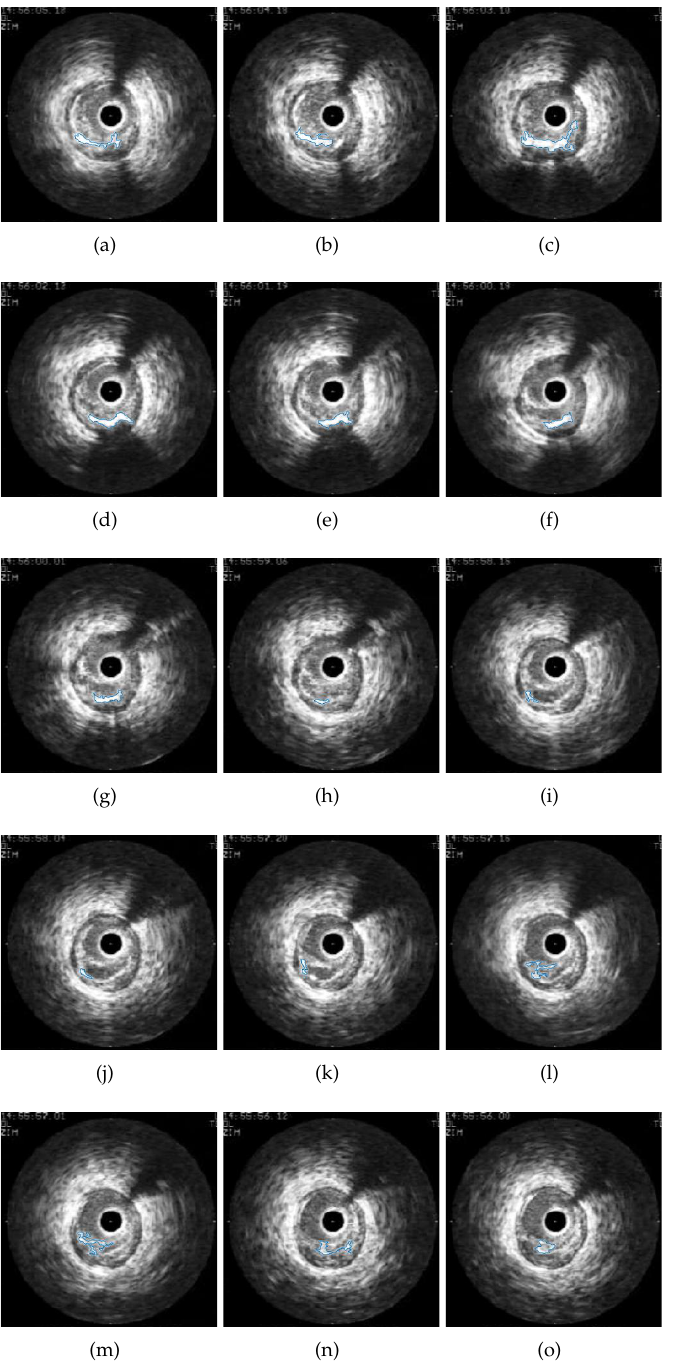
Figure A1. ( a – o ) Collection of the 15 images used to reconstruct the atheroma plaque of Figure